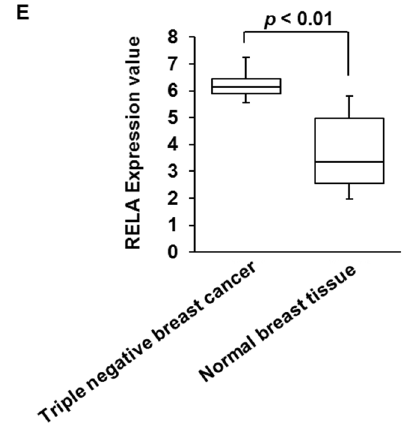
Figure 1. Activation of NF- κ B p65 was associated with poor prognosis in patients with TNBC. ( A ) Relation between phospho-NF- κ B p65 (Ser536) expression and overall survival. Survival rates were appraised using Kaplan − Meier Plotter. ( B ) High and low phospho-NF- κ B p65 (Ser536) expression groups were analyzed using Kaplan − Meier Plotter. ( C ) Relation between NFKBIA expression and overall survival. Survival rates were appraised using Kaplan − Meier Plotter. ( D ) High and low NFKBIA expression groups were analyzed using Kaplan − Meier Plotter. ( E ) Expression of RELA in TNBC and normal tissues was analyzed using the GSE45827 dataset.